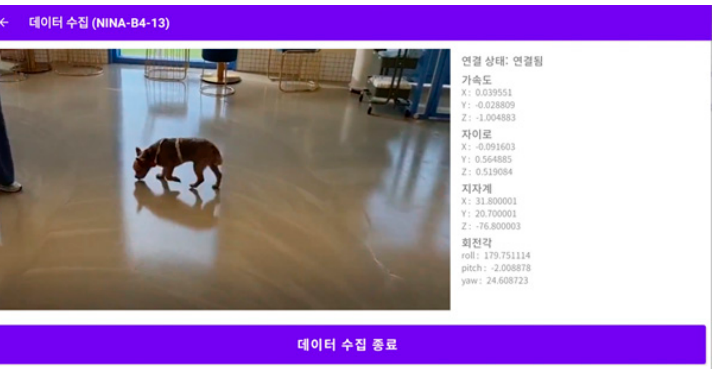
Figure 5. Application data collection screen. 데이터 수집 : Data Collection. 연결 상태 : 연결됨 Status: connect. 가속도 : accelerometer. 자이로 : gyroscope. 지자계 : geomagnetic. 회전각 : angle of rotation. 데이터 수집 종료 : End Data Collection.